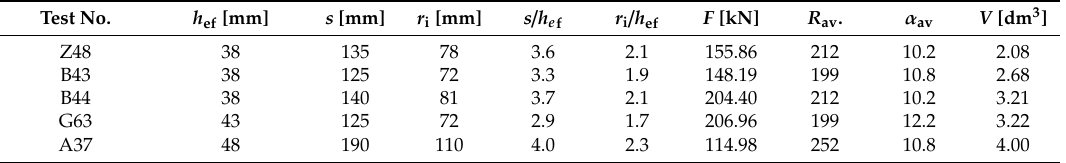
Table 4. Anchor group—3 anchors Hilti M12. Parameters and test results.